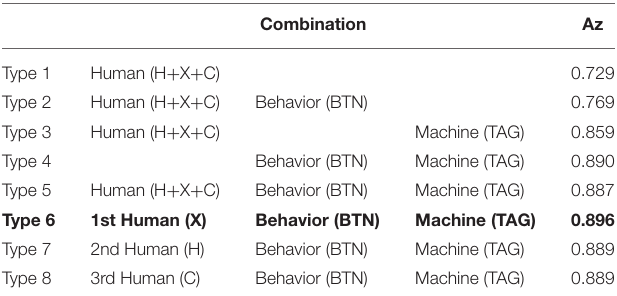
TABLE 2 | Different fusion strategies using the fuzzy decision-making fuser